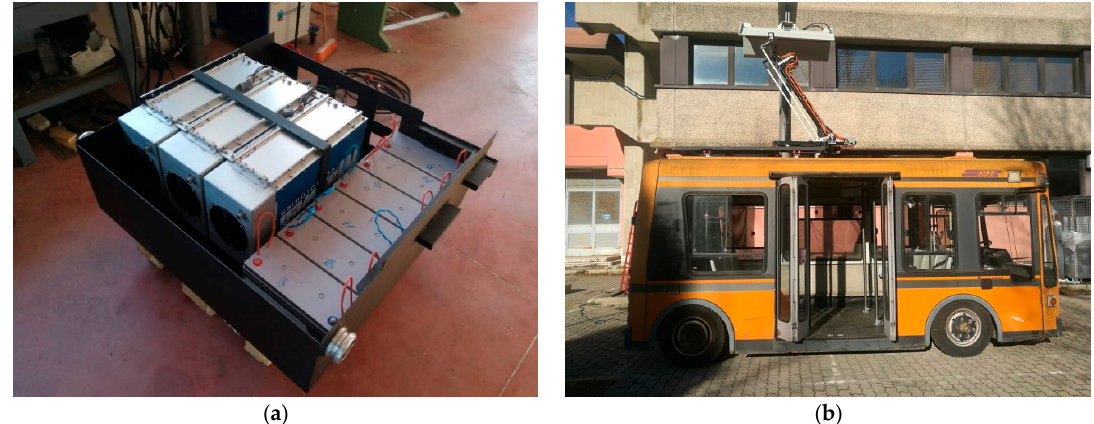
Figure 1. ( a ) Hybrid Storage system on board the bus; ( b ) and the pantograph for ultrafast charge.